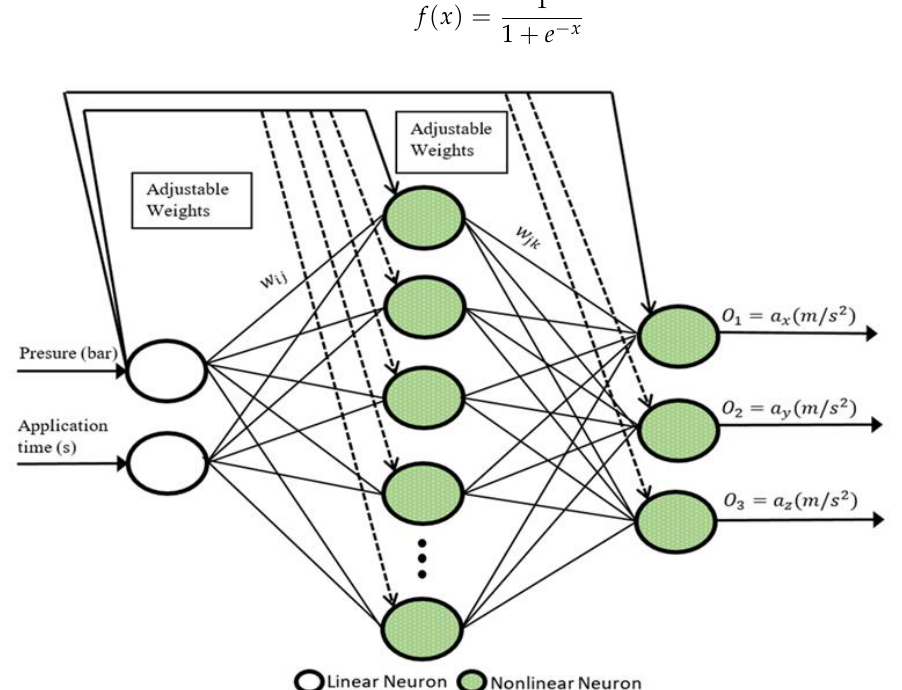
Figure 6. The CFBANN structure used in the simulations.